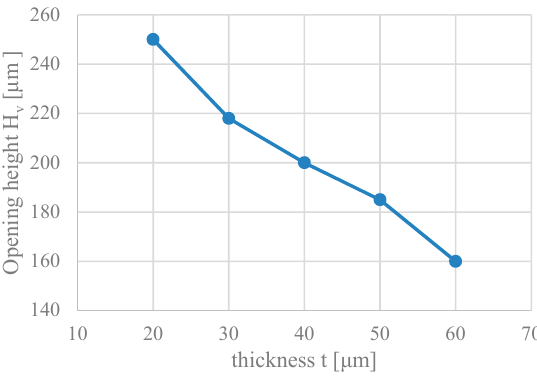
Figure 12. The relationship between thickness t and valve opening height H v , when R D = 1.2.